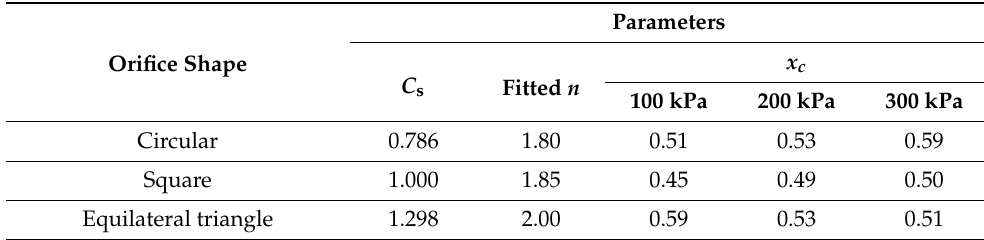
Table 3. Rosin–Rammler parameters of the droplet size distribution for different